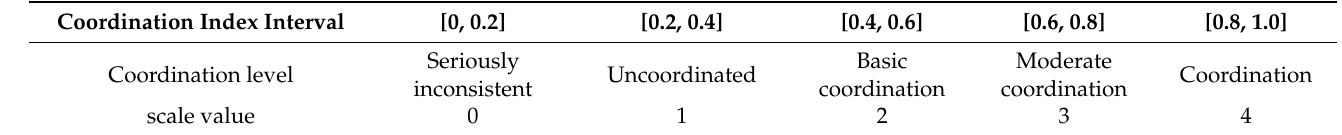
Table 6. Classification of system coordination in regional